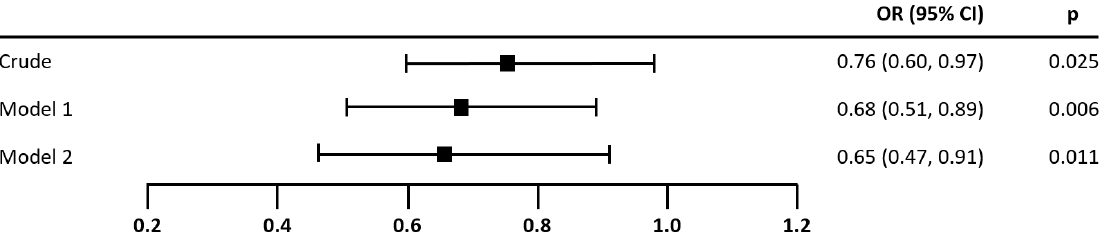
Figure 5. Association of HEI score with the presence of atrial fibrillation. Note. N = 104. Odds ratios (OR) for the presence of atrial fibrillation per 7.86 points increase in HEI. The maximum score of the HEI was scaled down from 110 to 14 for the logistic regression, in order to make the results compa- rable to MEDAS. Model 1 was adjusted for income, resting heart rate, log MET, energy intake, and diet change in the past year. Model 2 was additionally adjusted for log NT-proBNP. The odds ratio for log NT-proBNP in Model 2 was significant: OR (95% CI) = 36.71 (7.74–174.17), p < 0.001. Wellness of fit, correct predictions, and overall model-fit statistics—Crude: Nagelkerke’s R 2 = 0.112, 61.54%, Chi 2 = 9.15, p = 0.002, Model 1: Nagelkerke’s R 2 = 0.173, 63.46%, Chi 2 = 14.49, p = 0.043, Model 2: Nagelkerke’s R 2 = 0.476, 79.81%, Chi 2 = 45.92, p < 0.001. 4. Discussion To our knowledge, this matched case–control study among AF patients with limited risk-factor burden was the first to account for potential confounders before investigating dietary patterns and their relationship to the presence of AF and known AF risk factors. Our findings indicate that (a) the dietary patterns of patients with prevalent AF were poorer than those of age-, gender- and risk factor-matched control individuals, both in terms of adherence to individual foods such as nuts, vegetables and fruits, and to MEDAS and HEI overall; (b) MEDAS and HEI both correlated with AF-related risk factors such as BMI and resting heart rate in patients with AF; (c) the adherence to healthy dietary pat- terns measured by both MEDAS and HEI was independently negatively associated with the presence of AF, even after adjustments; and (d) inclusion of NT-proBNP as a typical blood biomarker for AF remains significant. Lifestyle and nutrition have already been shown to be influencing factors for a mul- titude of cardiovascular conditions [19]. Additionally, the incidence and prevalence of AF is increasing in ageing societies [4]. According to the guidelines of the European Society of Cardiology, in addition to age, about 50% of the known risk factors for AF are associ- ated with lifestyle, leading to diseases such as diabetes, dyslipidaemia, hypertension, obe- sity, and early coronary heart diseases [21]. Consequently, lifestyle changes are recom- mended, including reduction of weight, lower alcohol consumption, and smoking cessa- tion, as well as increased regular exercise. Although individual aspects of nutrition have